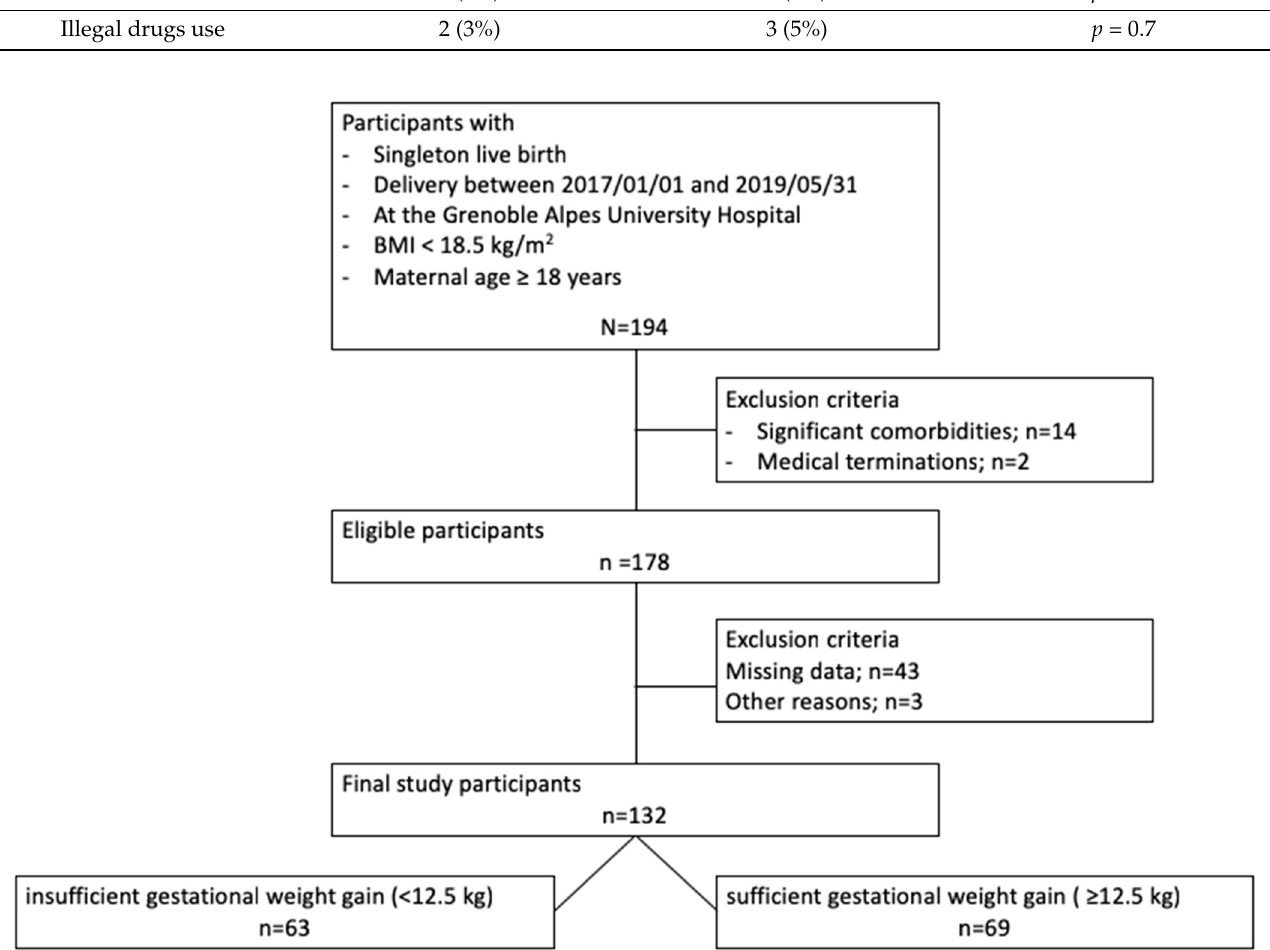
Figure 1. Flowchart of the study; BMI: body mass index.